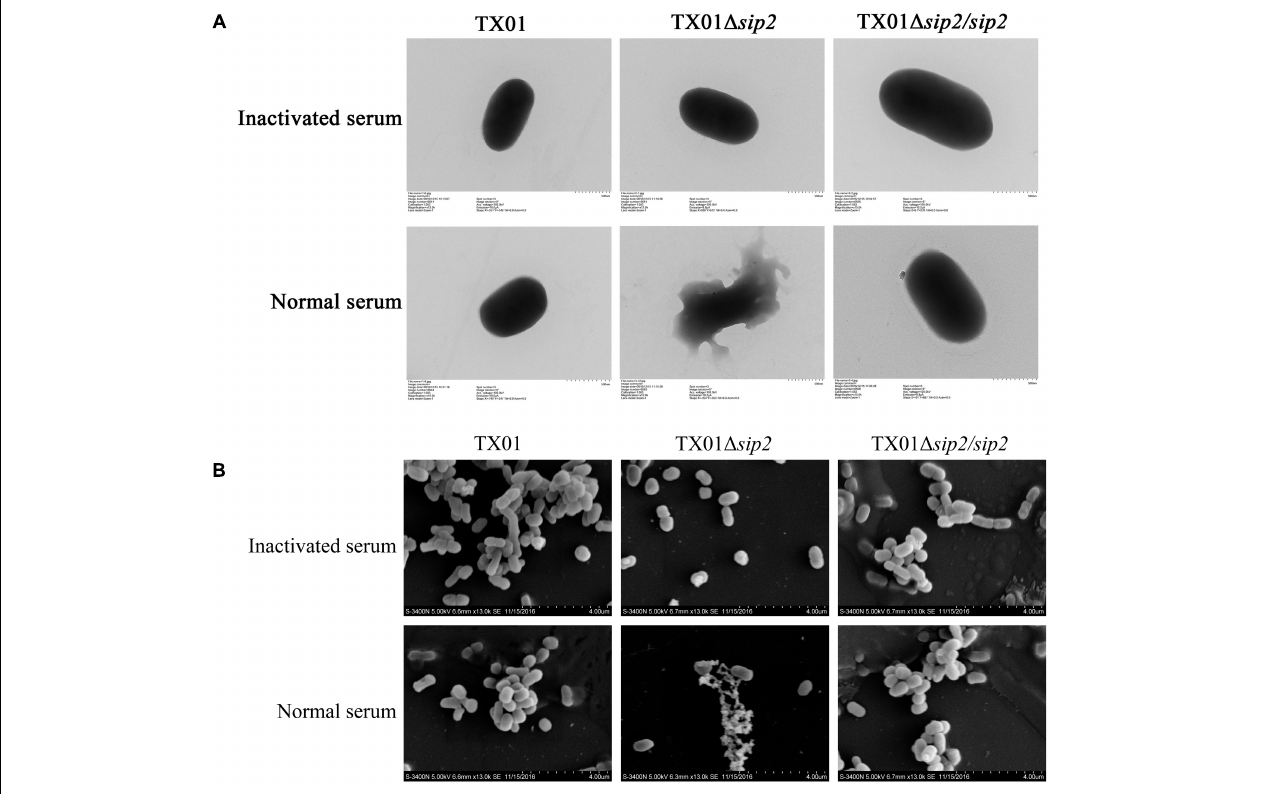
FIGURE 2 | Microscopic examination of the effect of serum treatment on Edwardsiella tarda . TX01, TX01 (cid:49) sip2 , and TX01 (cid:49) sip2 / sip2 were treated with normal or heat-inactivated (control) tongue sole serum for 1 h and then subjected to transmission (A) and scanning microscopy (B) .